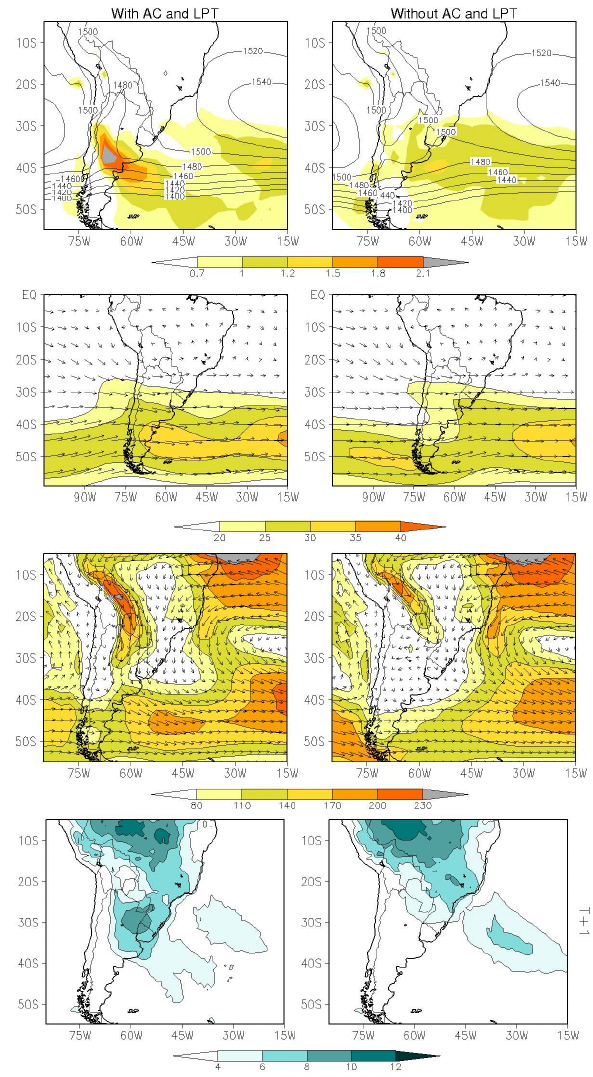
Fig. 3. Composites for cases with (left) and without (right) AC and LPT inside the selected region. From top to bottom, the panels show geopotential height (m) and FG 3 (K / 100km / day) at 850hPa, wind vectors and its magnitude (m/s) at 250hPa, vertically integrated humidity transport and its magnitude (kg / m / s), and precipitation (mm / day) with 1-day